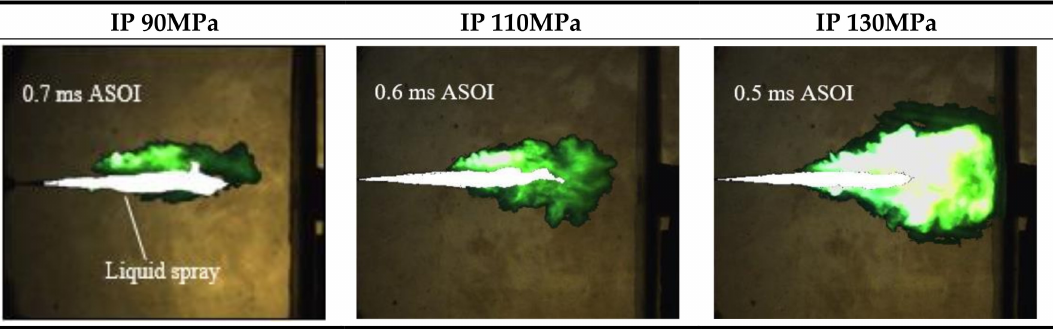
Figure 9. Ignition images under di ff erent IP.